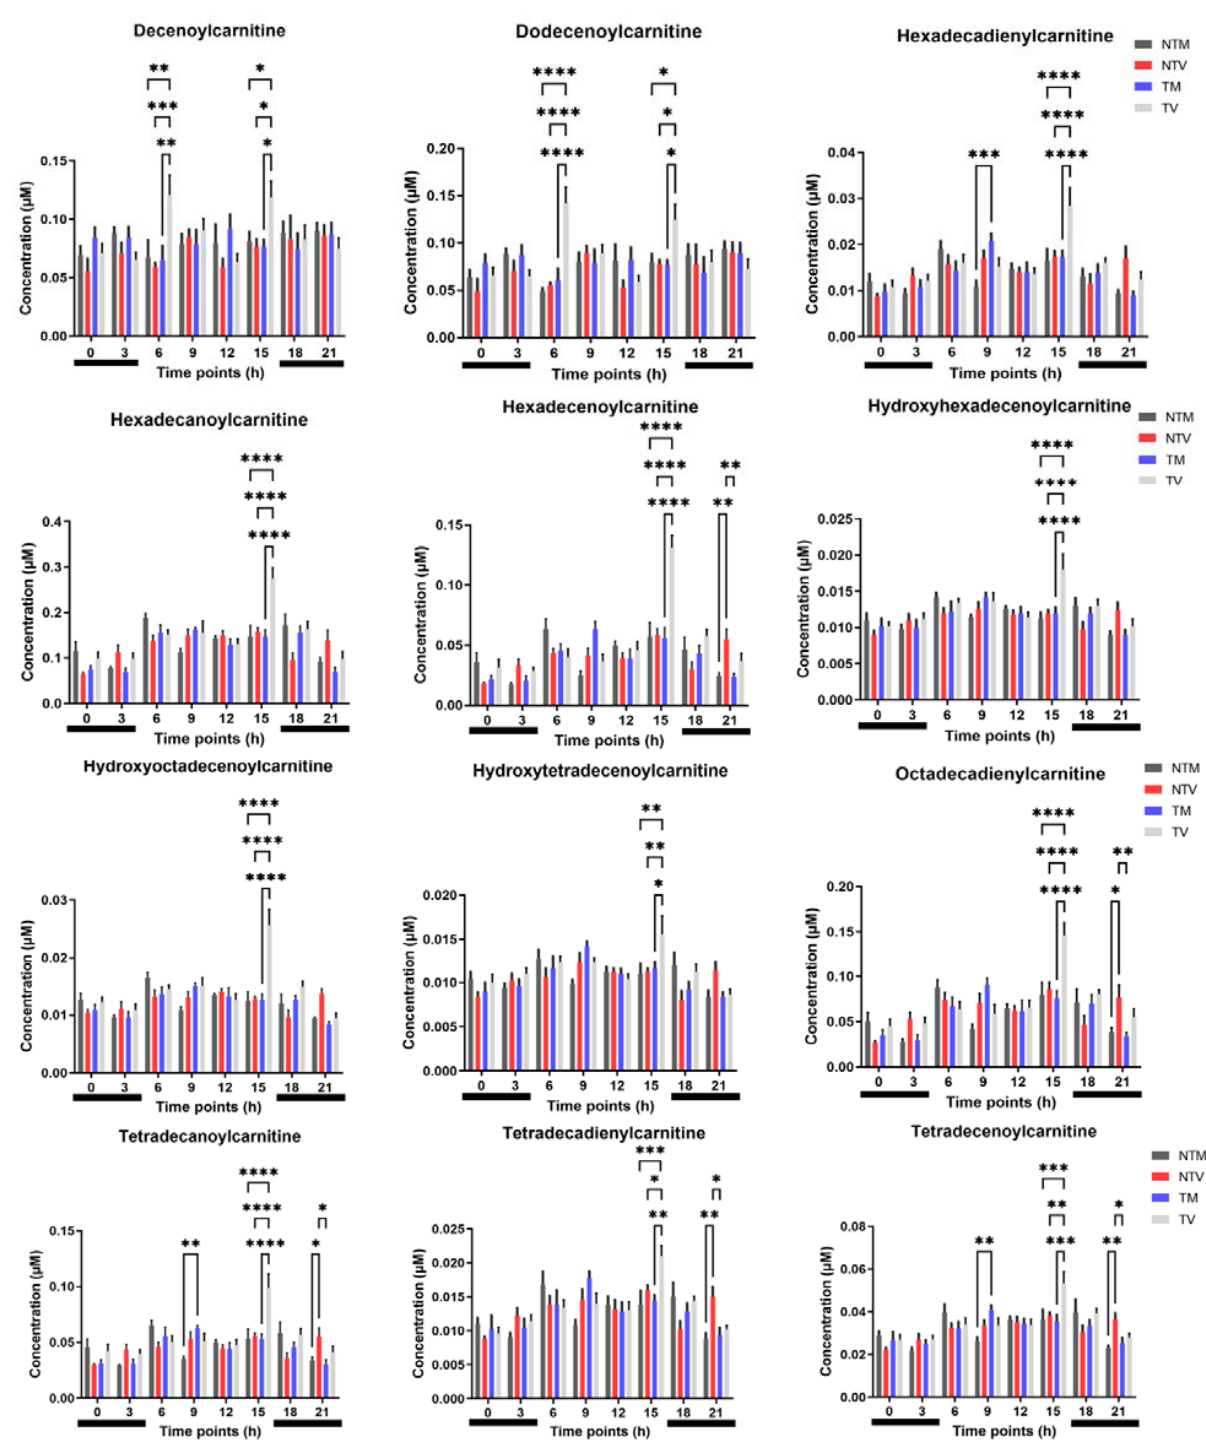
Figure 4. Concentration of plasma acylcarnitines in BC-bearing mice. Acylcarnitines were measured at eight time points after treatment with melatonin or vehicle only. Light phases included 06:00, 09:00, 12:00, and 15:00. Dark phases included 18:00, 21:00, 00:00, and 03:00 (horizontal black bars). Data represent the mean ± SD of the concentrations (µM) among the experimental groups (NTM: non-tumor treated with melatonin; NTV: non-tumor treated with vehicle; TM: tumor treated with melatonin; TV: tumor treated with vehicle). Two-way ANOVA complemented with Tukey’s multiple comparisons test. * p < 0.05, ** p < 0.01, *** p < 0.001, **** p <